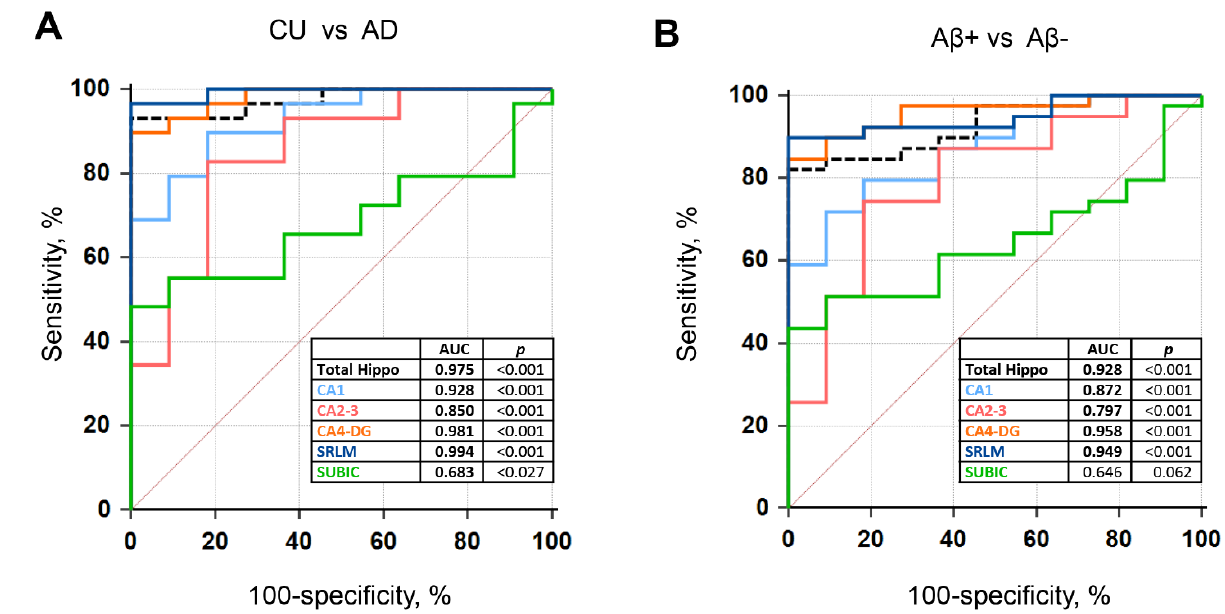
Figure 3. Receiver operating characteristic (ROC) curves of the hippocampal subfield volumes. ( A ) AD from CU ( B ) Aβ+ vs. Aβ− . Abbreviations: CU = cognitively unimpaired, AD = Alzheimer’s disease, Aβ = Amyloid - β, Total Hippo = whole hippocampus volume .